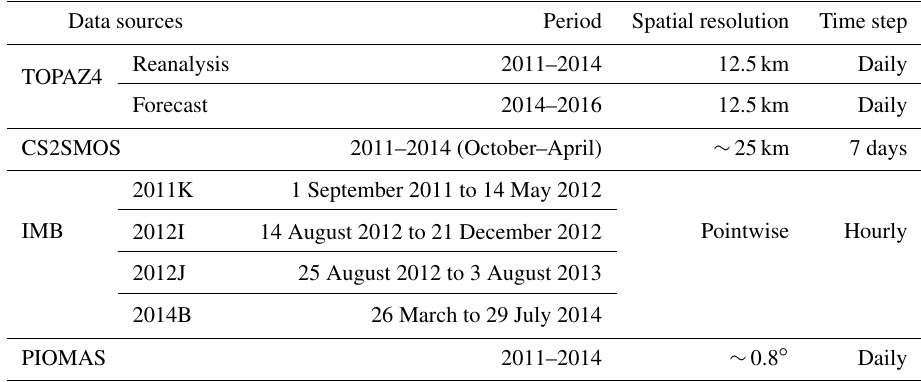
Table 1. List of observed and simulated sea ice thickness data sets.